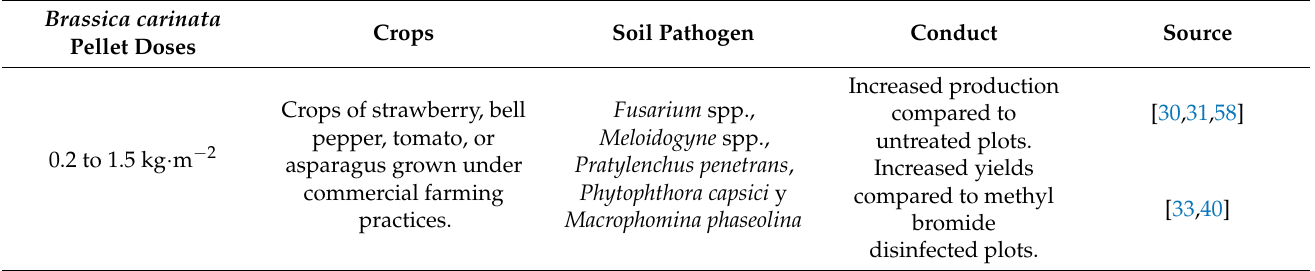
Table 5. Effect of Brassica carinata pellets with biosolarization on the yield of several crops affected by soil